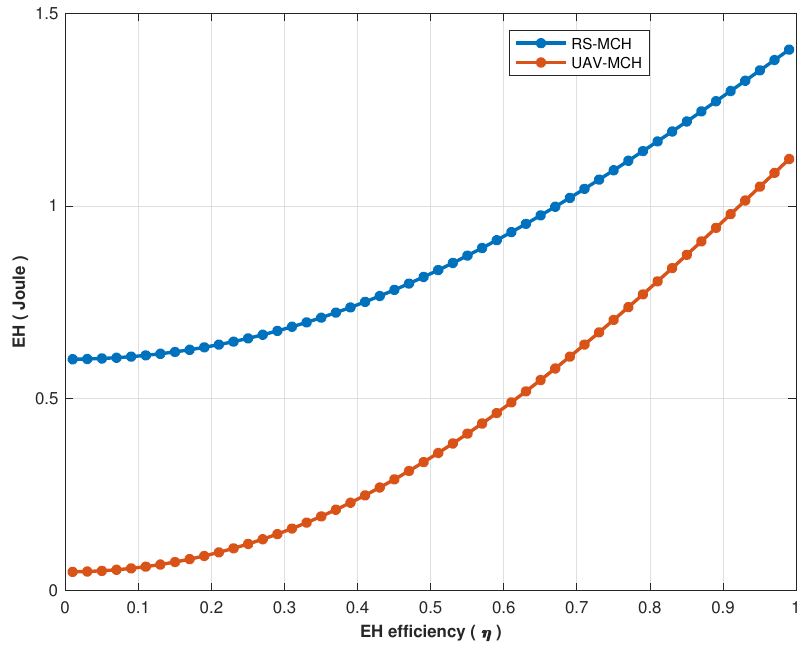
Figure 12. EH performance vs. energy harvesting efficiency ( η ) for RS and